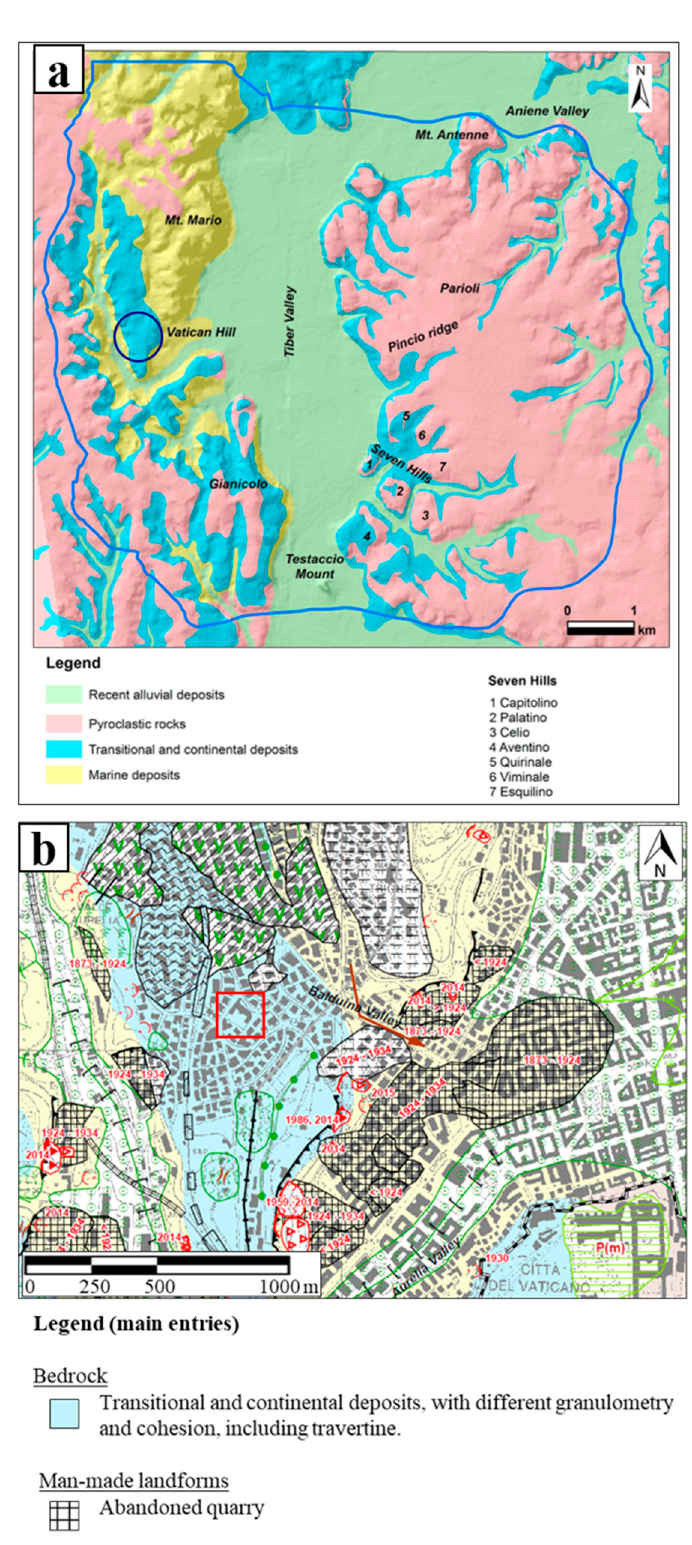
Figure 2. ( a ) Geological sketch of Rome, the blue circle indicates the Balduina district (modified from [8]); ( b ) Geomorphological map of Rome developed comparing different dataset, the red polygon indicates the study area (modified from [8]).